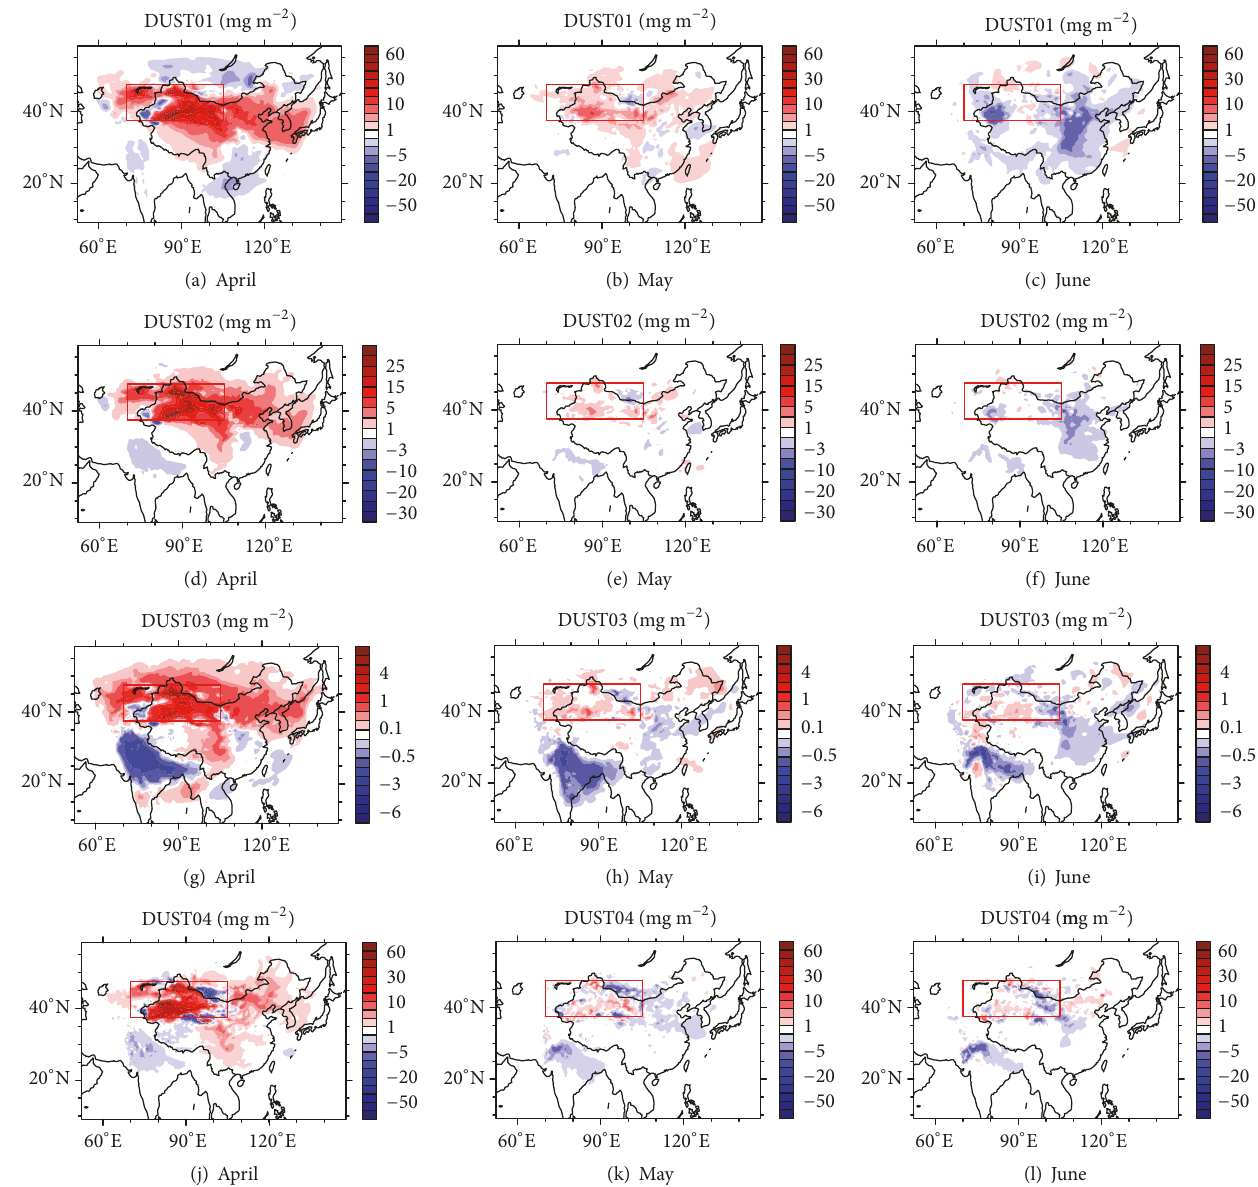
Figure 11: The DIF (SE − CE) of the tracer total burden (mgm −2 ) of the four dust bins (DUST01–DUST04) in April, May, and June averaged from 2001 to